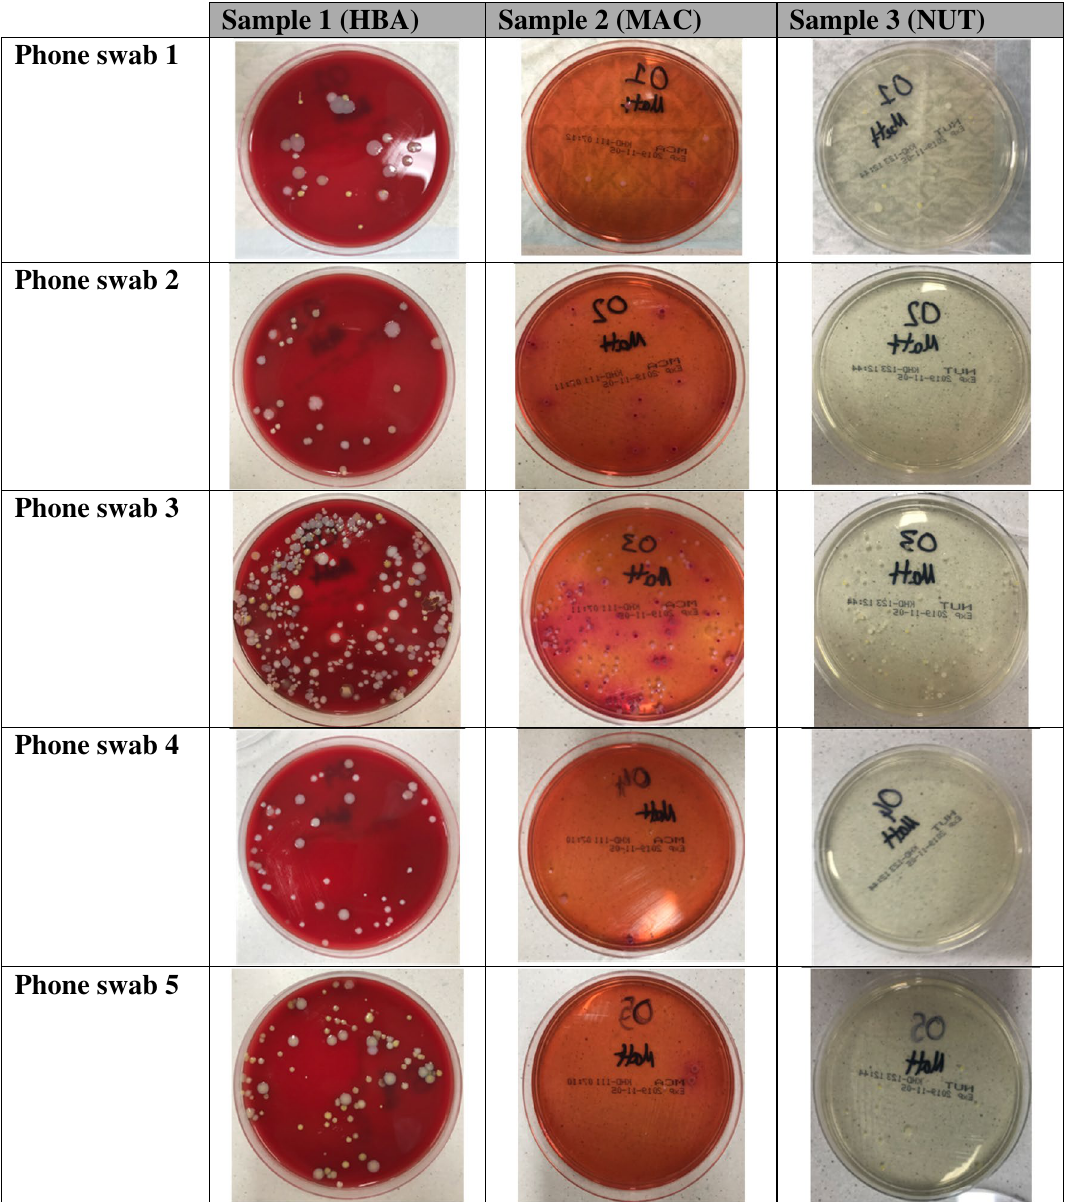
Figure 1. Sample growths of 5 community derived phone swabs on three different agar plates (HBA, MAC,